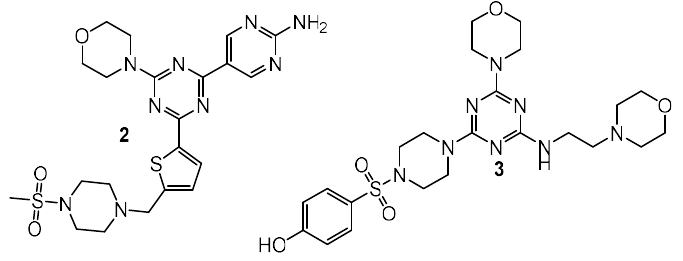
Figure 2. Structure of dual PI3K and mTor inhibitors.